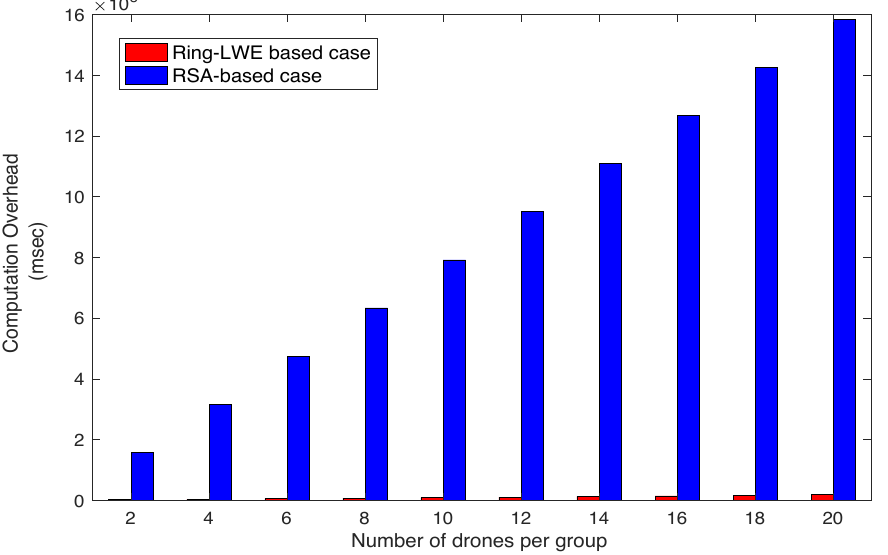
Figure 10. Computation overhead for a group Ring-LWE-based proposed scheme versus an RSA-based